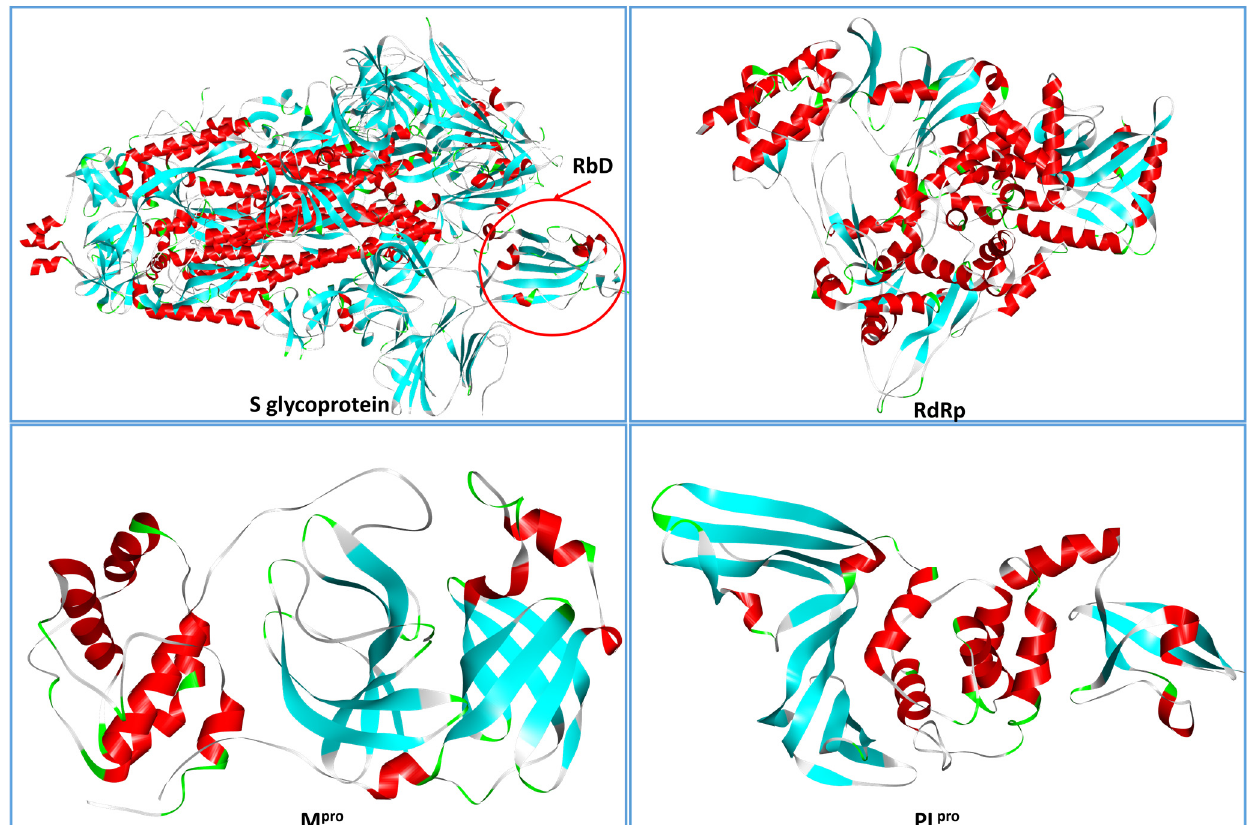
Figure 5. The four main proteins of SARS-CoV-2 represented by the backbone ribbon. Colors refer to helices (red), beta strands (cyan), turns (green), and generic loops (grey). Images are generated by DiscoveryStudio 4.5 (Dassault Systèmes, France).